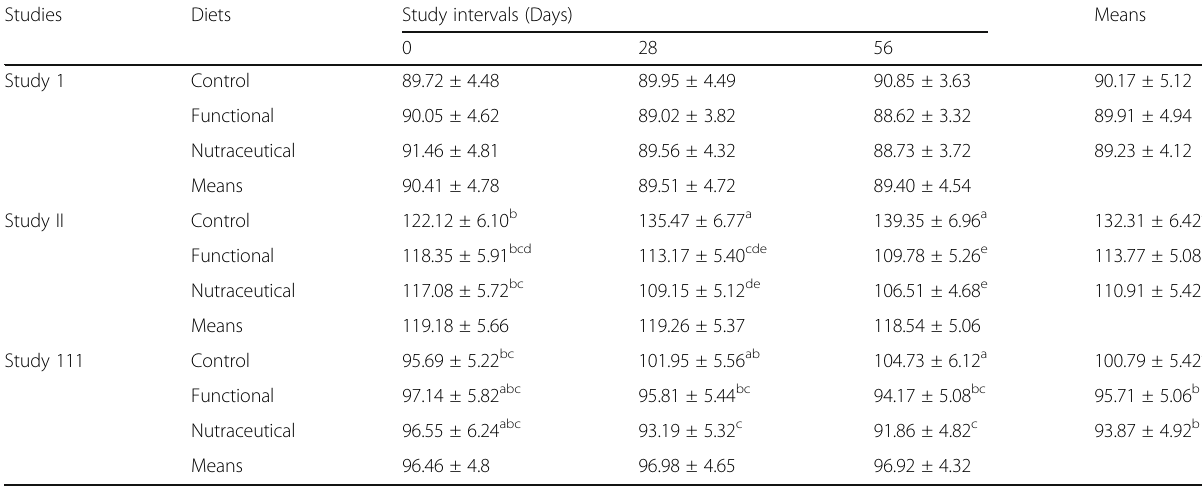
Table 2 Effect of diets and study intervals on glucose level (mg/dL) of rats in different studies Studies